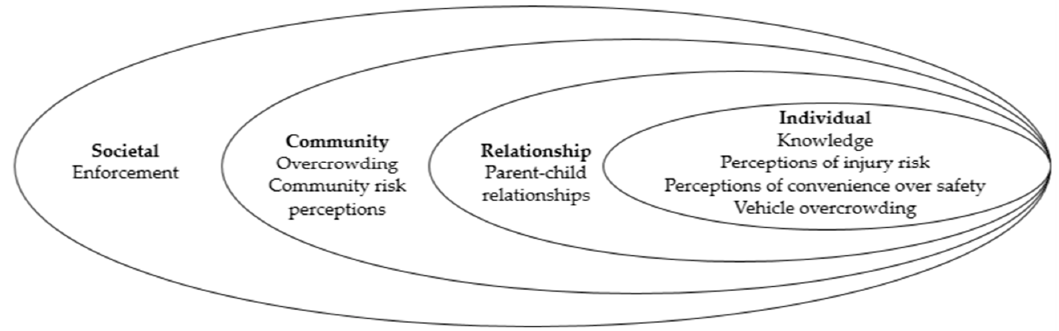
Figure 1. Social-ecological model applied to describe factors a ff ecting child car restraint use from participant